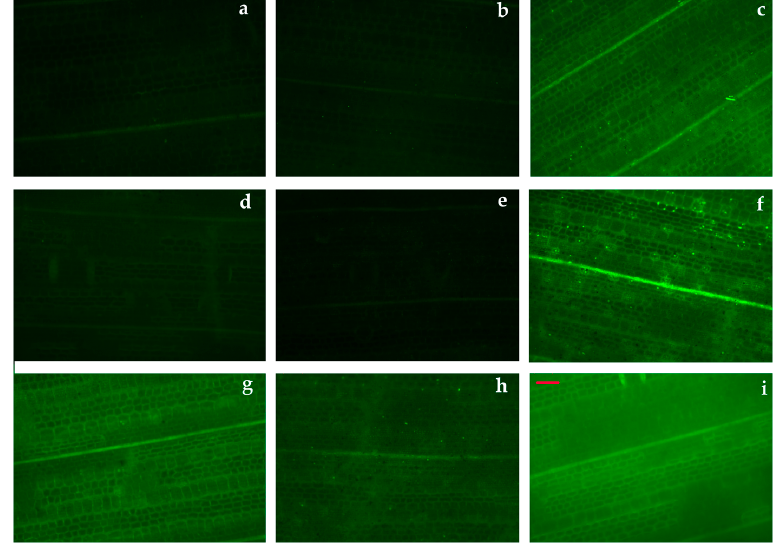
Figure 11. Representative patterns of H 2 O 2 production in C. nodosa control leaf blades and after exposure to 5 mg L − 1 and 10 mg L − 1 ZnO NPs, as indicated by the fluorescence of H 2 DCF-DA. The H 2 O 2 real-time generation in control leaf blade ( a ); after a 4-h exposure to 5 mg L − 1 ( b ); after a 4-h exposure to 10 mg L − 1 ( c ); after a 24-h exposure to 5 mg L − 1 ( d ); after a 24-h exposure to 10 mg L − 1 ( e ); after a 48-h exposure to 5 mg L − 1 ( f ); after a 48-h exposure to 10 mg L − 1 ( g ); after a 72-h exposure to 5 mg L − 1 ( h ); and after a 72-h exposure to 10 mg L − 1 ( i ). Scale bare: 200 µ m. A higher H 2 O 2 content is indicated by light green